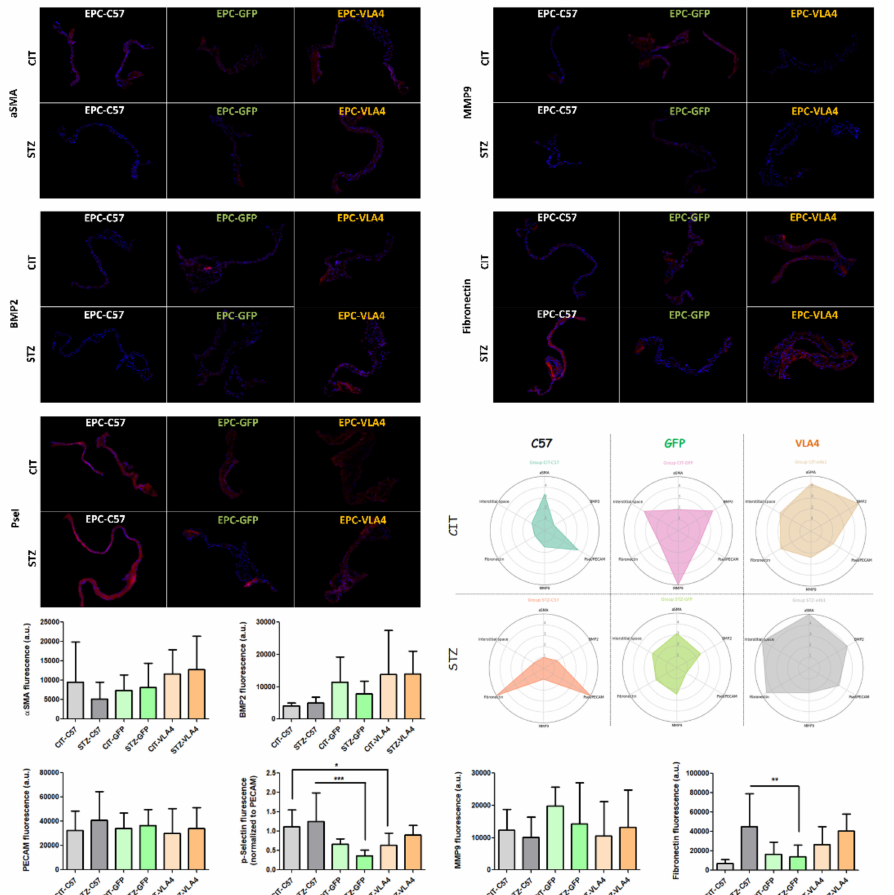
Figure 4. Representative immunochemistry images showing the inflammation and remodelling markers tested. The radio diagrams show the normalized profiles for each treatment condition obtained from the data shown in the bar graphs. The statistical differences were tested by Bonferroni Multiple Comparison Tests (CIT-EPC-C57 vs. CIT-EPC-GFP, CIT-EPC-C57 vs. CIT-EPC-VLA4, STZ- EPC-C57 vs. STZ-EPC-GFP and STZ-EPC-C57 vs. STZ-EPC-VLA4) and the significant results were noted as * p < 0.05, ** p < 0.01, *** p <